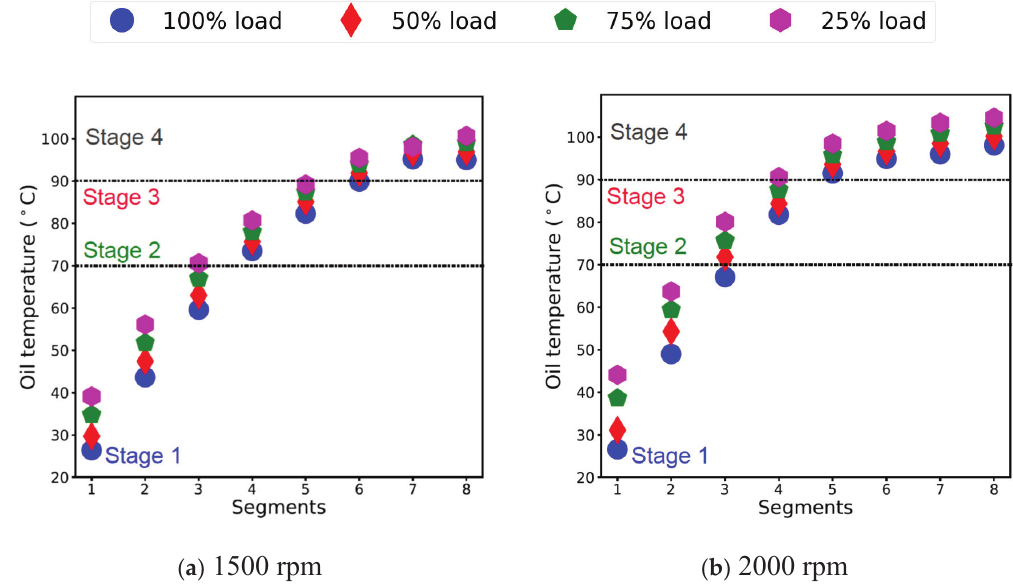
Figure 5. Lubricating oil temperature at each load in each segment at ( a ) 1500 and ( b ) 2000 rpm. The blue circle represents 100% load, the red diamond 50% load, the green pentagon 75% load and the pink hexagon 25%